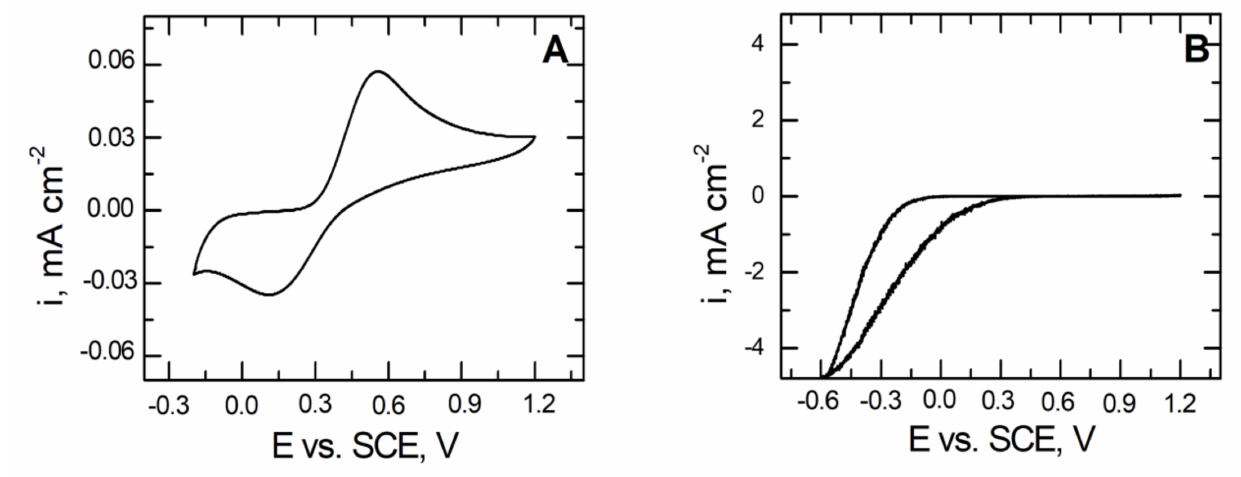
Figure 9. Voltammetric response for: glassy carbon ( A ) and coated X20Cr13 steel with VTMS/EtOH/AcOH ( B ). Electrolyte: 2 mmol dm − 3 K 3 [Fe(CN) 6 ]. Polarization rate 10 mVs − 1